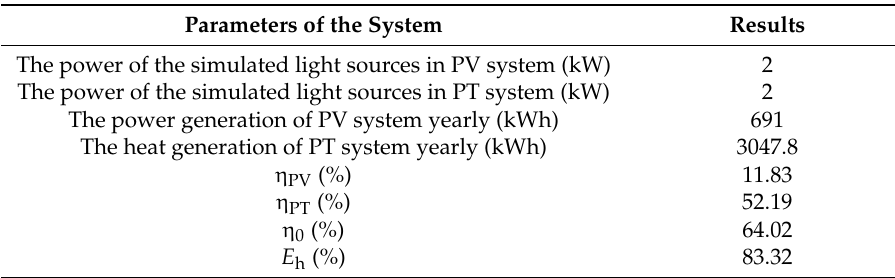
Table 6. Efficiency of the proposed movable hybrid PVT system. Parameters of the System